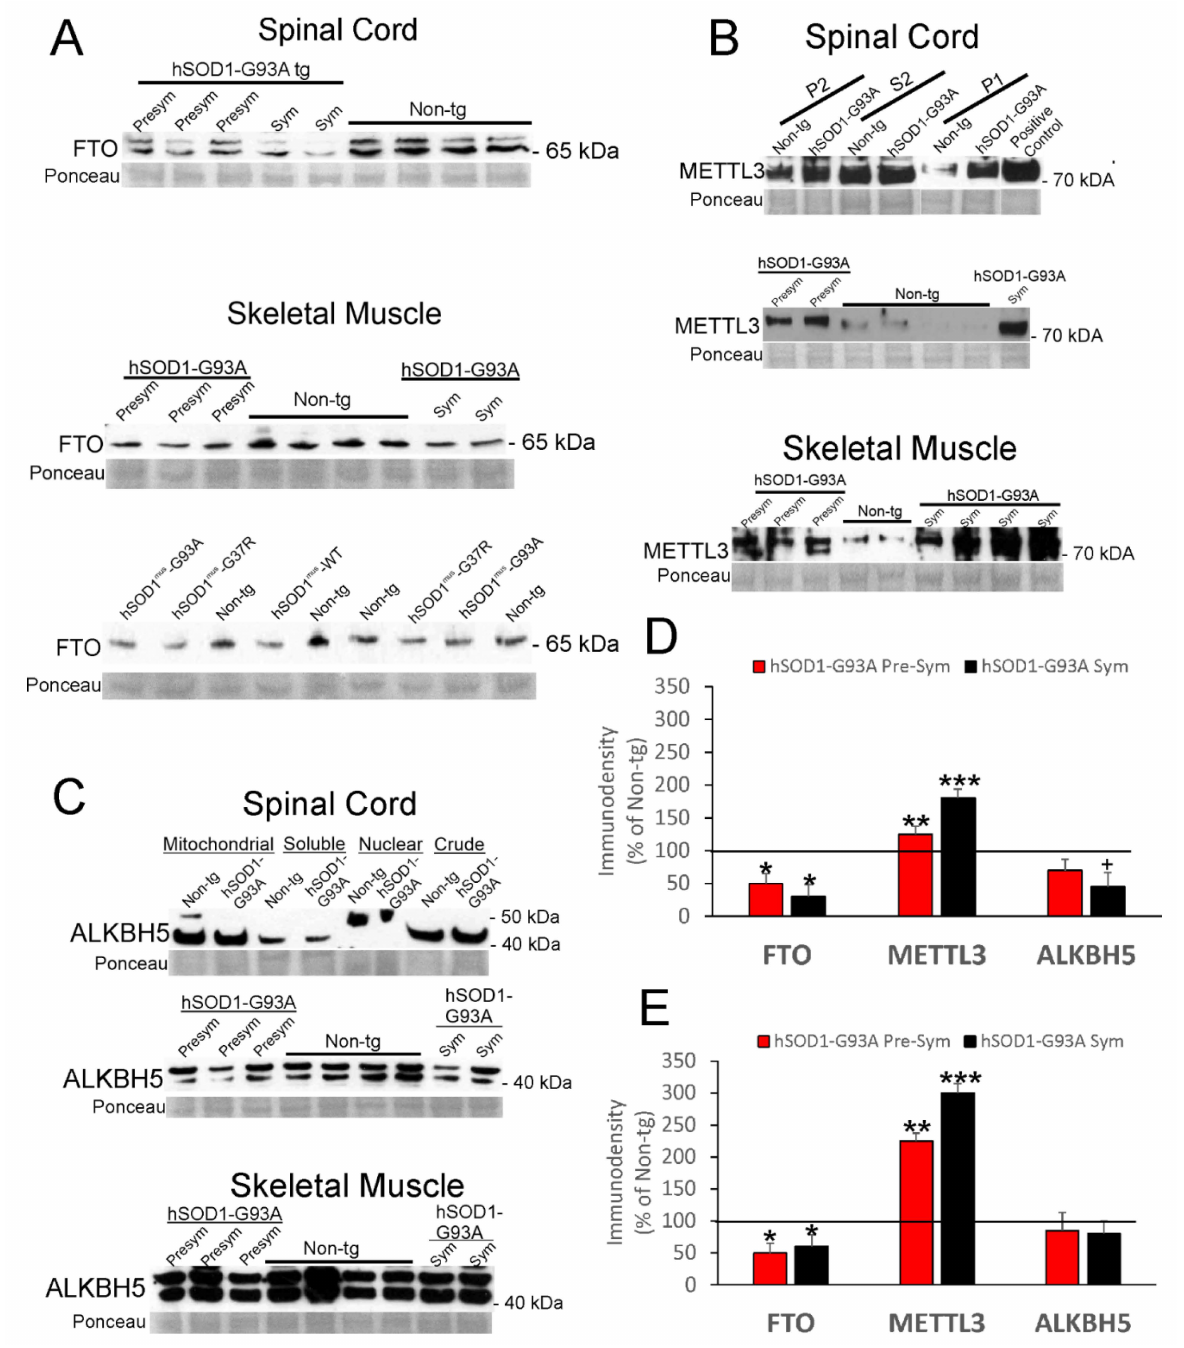
Figure 10. Western blot analysis of RNA methylation-related enzymes in spinal cord and skeletal muscle of hSOD1 tg mice. ( A ) FTO levels in spinal cord (( A ), top) and skeletal muscle (( A ), bottom) of nonconditional hSOD1 tg mice (presymptomatic and symptomatic) and conditional hSOD1 mus tg mice. Age-matched non-tg littermates were controls. The several different hSOD1 tg mouse lines